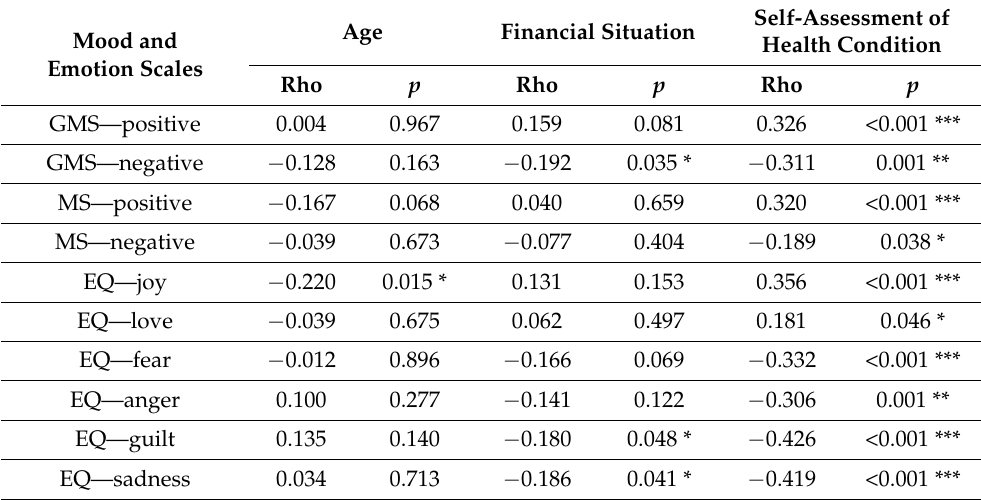
Table 3. Age, financial situation, and self-assessment of the health of the respondents and the mood and emotions.